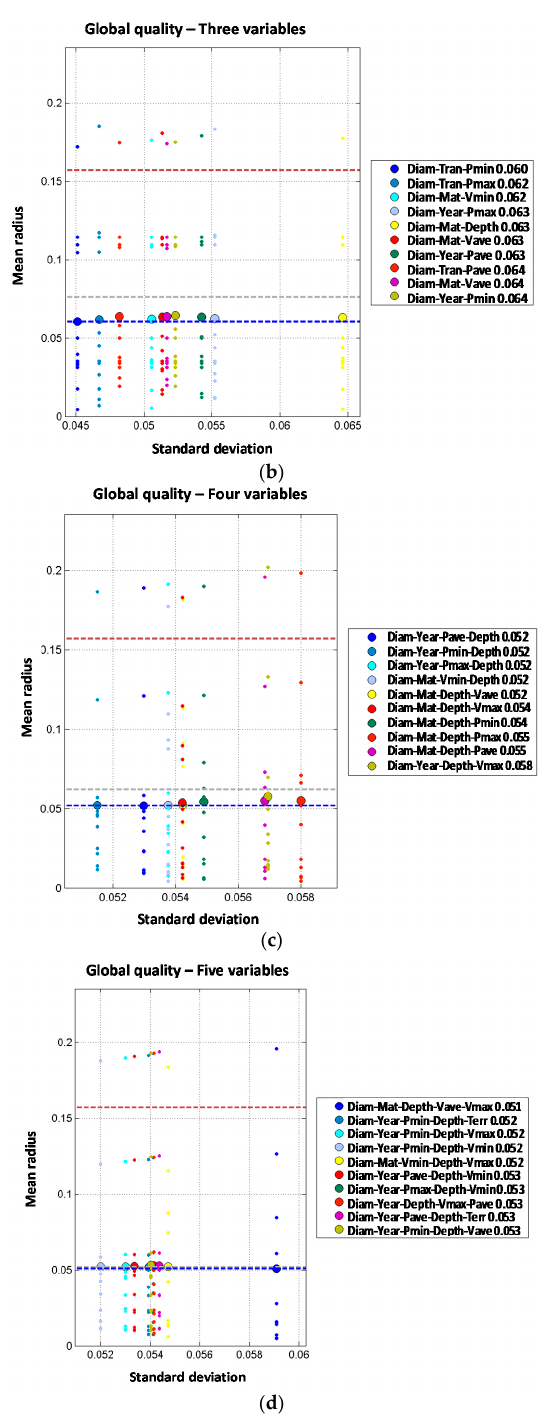
Figure 5. Distribution lines. Mean radius and standard deviation for models with two joint variables plus independent variables. Order zero mean radius is represented with brown dotted line; and best predictive model with blue line for: ( a ) order two; ( b ) order three; ( c ) order four; and ( d ) order five